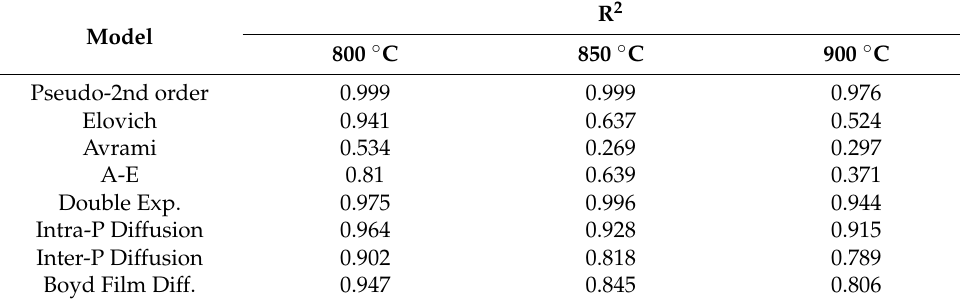
Table 5. R 2 for the various kinetic models evaluated for K-B.